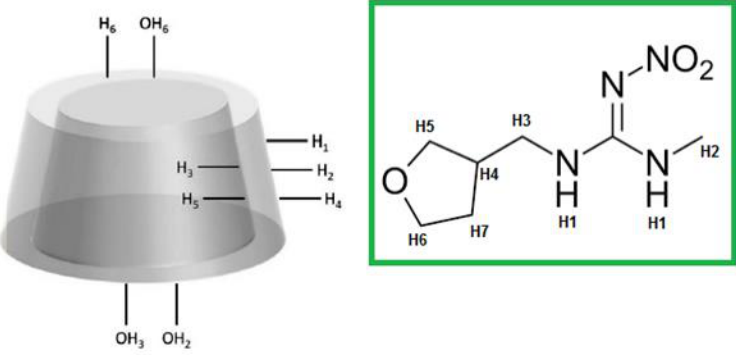
Figure 2. Proton assignments for the CD monomer and DTF.